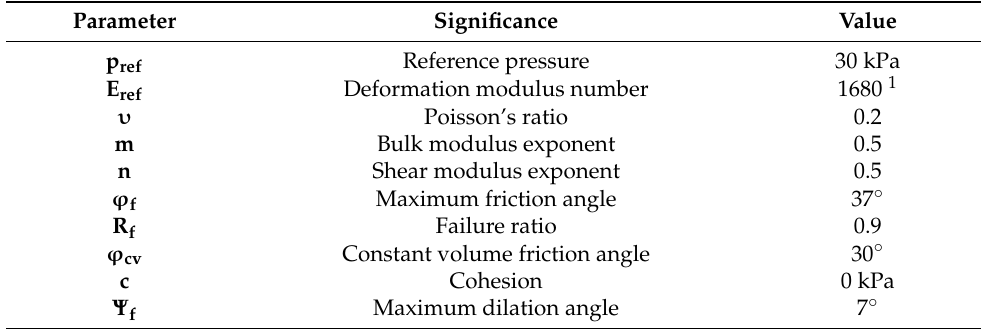
Table 2. Parameters of the CHsoil